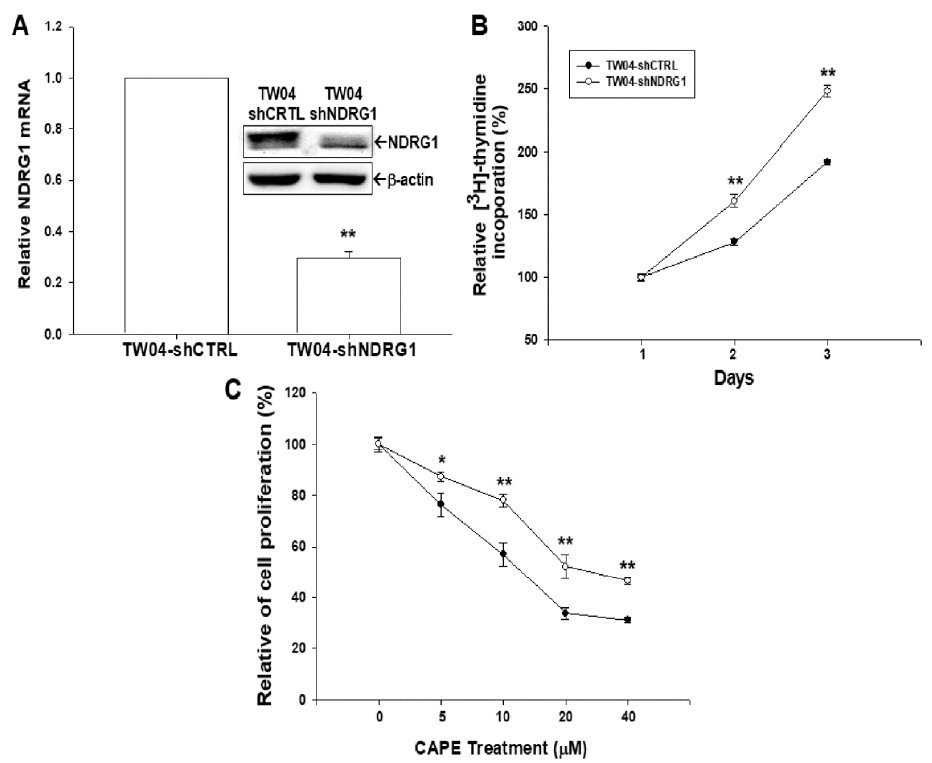
Figure 3. Knockdown of NDRG1 enhances cell growth in TW04 cell. ( A ) The expressions of NDRG1 in TW04-shCTRL and TW04-shNDRG1 cells were determined by immunoblot (top) and RT-qPCR (bottom) assays. ( B ) Proliferations of TW04-shCTRL (●) and TW04-shNDRG1 ( ○ ) cells were